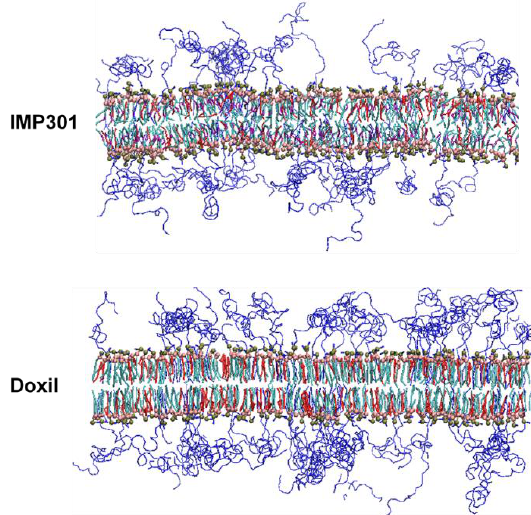
Figure 12. Side views of final configurations for IMP301 and DOXIL bilayers. Lipid headgroups and tails are respectively represented as brown (phosphate)/pink (glycerol) dots and light-blue lines, while cholesterol and PEG are colored in red and blue lines, respectively. For clarity, water and counterion molecules are omitted.